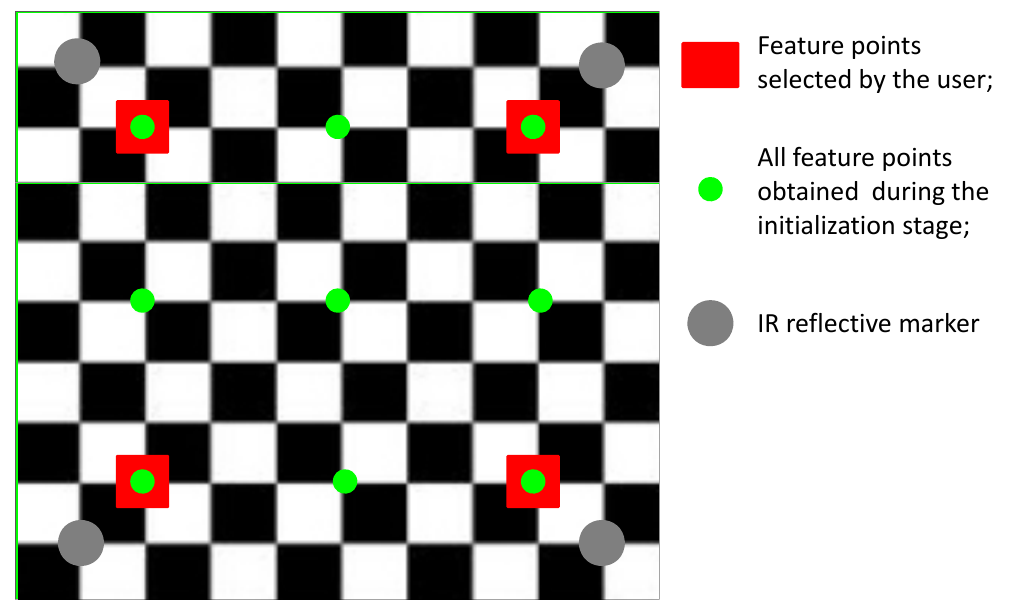
Figure 2. The nine feature points constructed during the initialization stage are shown. Red squares: the four feature points manually selected by the user; green circles: the nine feature points constructed during the initialization